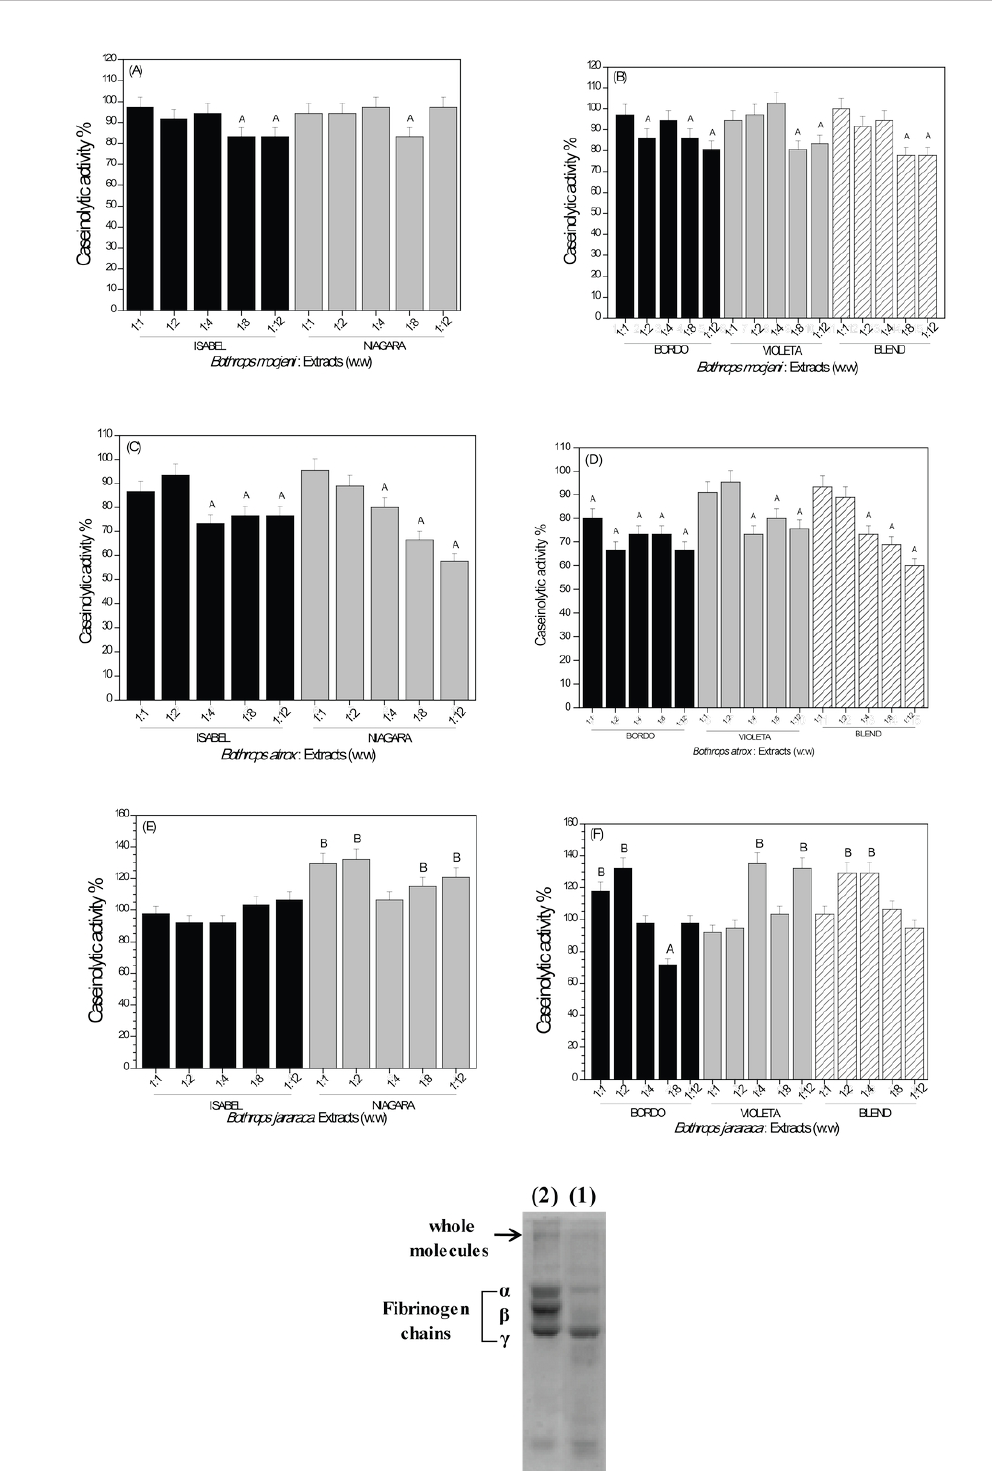
FIGURE 1 - Proteolysis activities. Effect of dried grape pomace from different cultivars on venom induced caseinolytic activity of Bothrops moojeni (A and B), B. atrox (C and D) and B . jararaca venoms (E and F). Controls (+) containing only venom (30 μg) were considered as 100% activity. A = differs from the positive control in inhibition. B = differs from the positive control in potentiation. Illustrative figure of the effect of dried grape pomace from different cultivars on the venom induced fibrinogenolytic activity of B. moojeni and B. atrox (60 μg) (G). Previously incubated with fibrinogen (60 μg) alone or in the presence of dried pomace evaluated in ratios 1: 4 and 1: 8 (w: w). (1) α , β and γ chains of widely fragmented fibrinogen molecules in the presence of pure venom. (2) α , β and γ chains of intact fibrinogen molecules after incubation of grape extract with